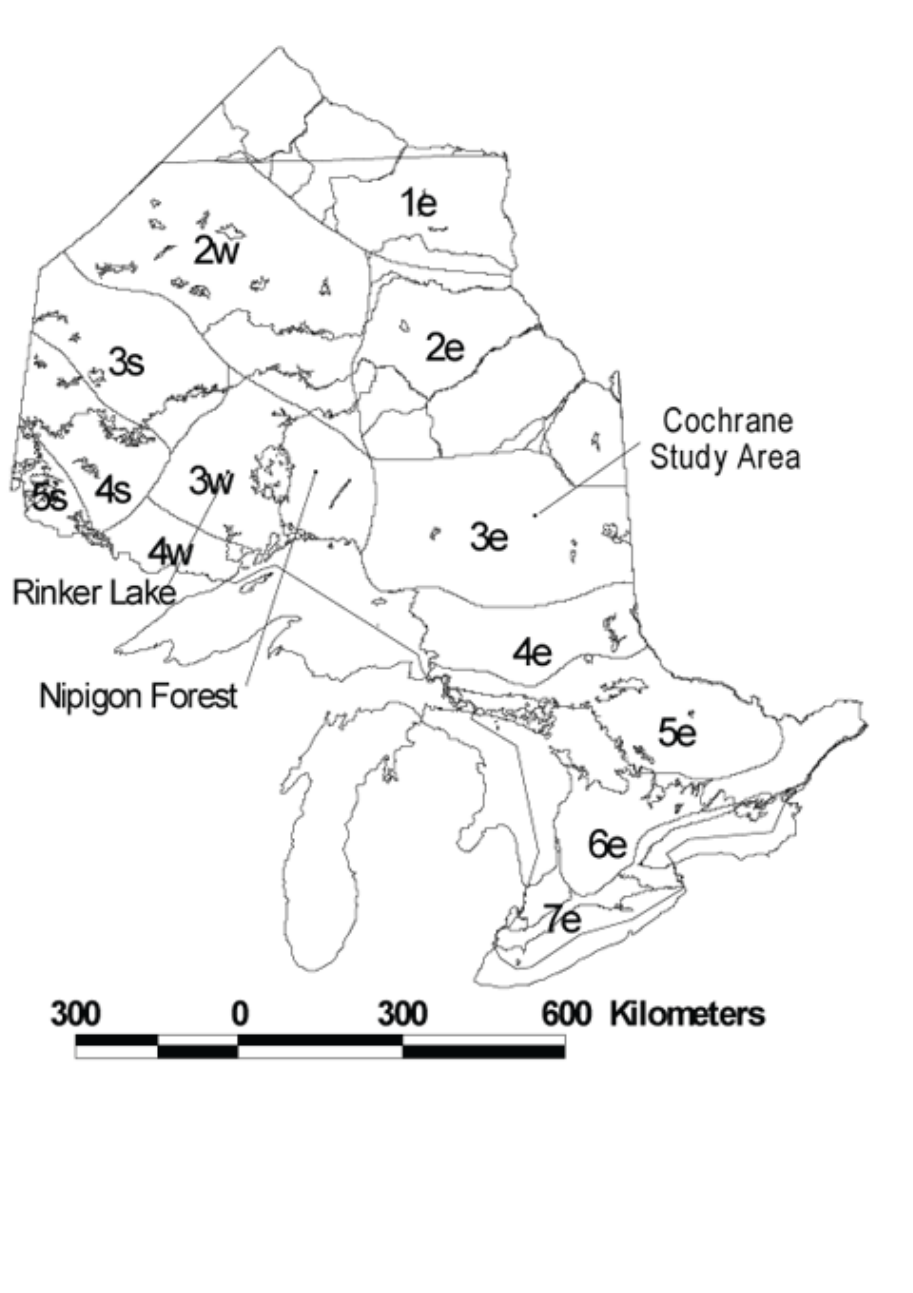
Fig. 3. Location of Rinker Lake, Nipigon Forest, and Cochrane Study Area study sites. Ecoregions based on Hills (1961), where 5S, 4S, and 3S are sub-humid, 4W and 3W are dry-humid, and 3E and 2E are